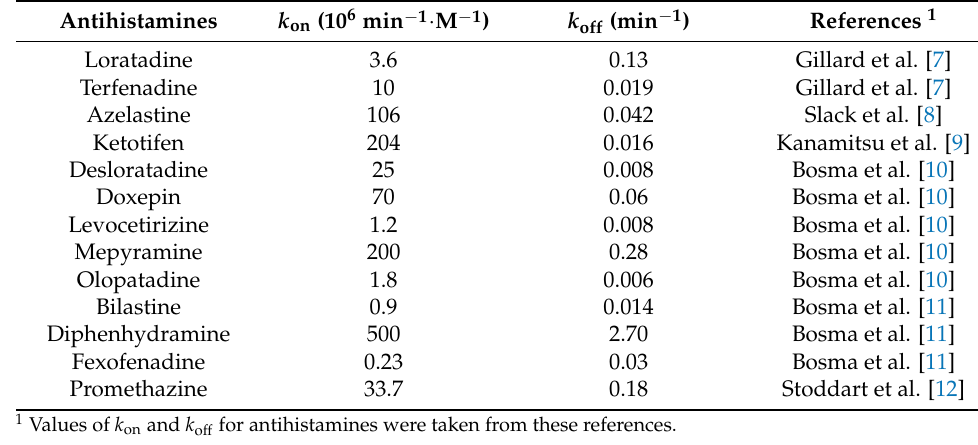
Table 1. Kinetic binding parameters for antihistamines used in this study.